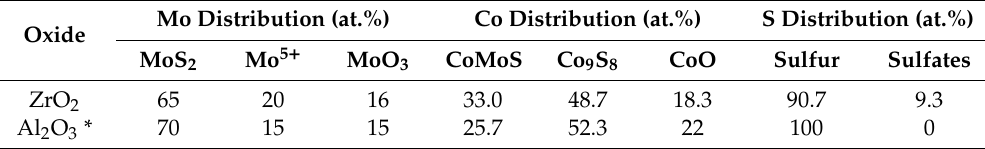
Table 1. Percentage obtained by XPS analysis of the phases formed after sulfidation. Mo Distribution (at.%) Co Distribution (at.%) S Distribution (at.%) Oxide